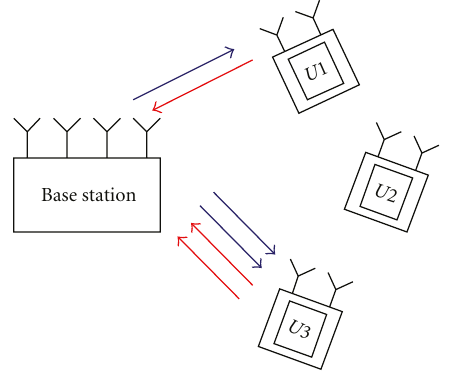
Figure 2: Example of uplink-downlink beam